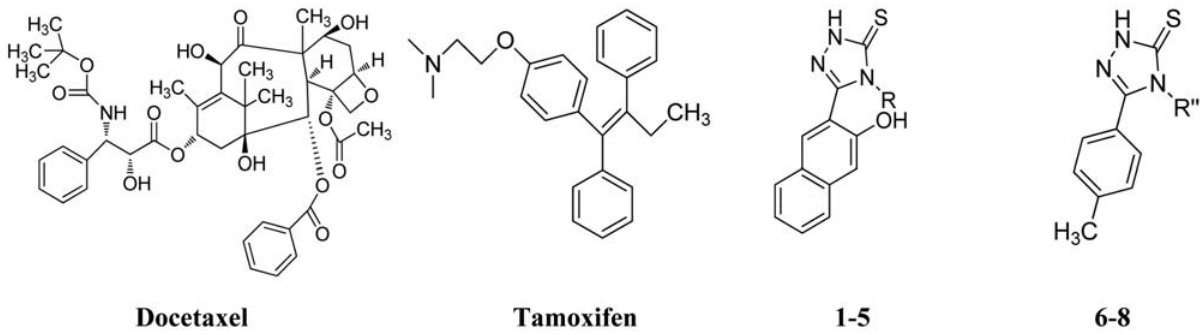
Figure 1. Chemical structures of standard drugs and tested compounds (1–8)